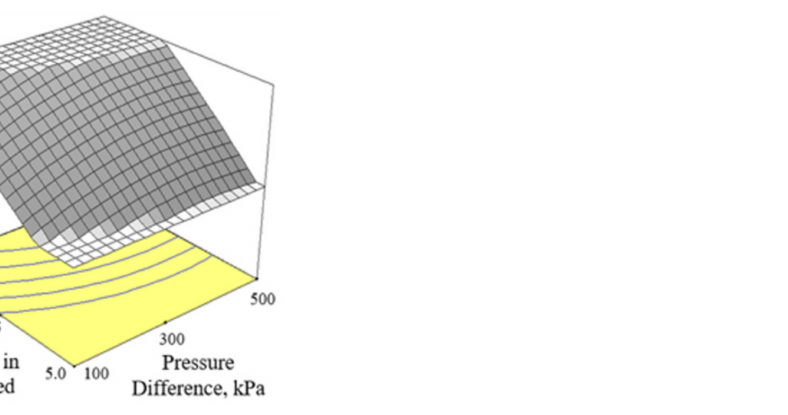
Figure 3. Effect of interaction between CO 2 % in the feed and pressure difference on the 1/(CO 2 permeance) at 105 ◦ C.